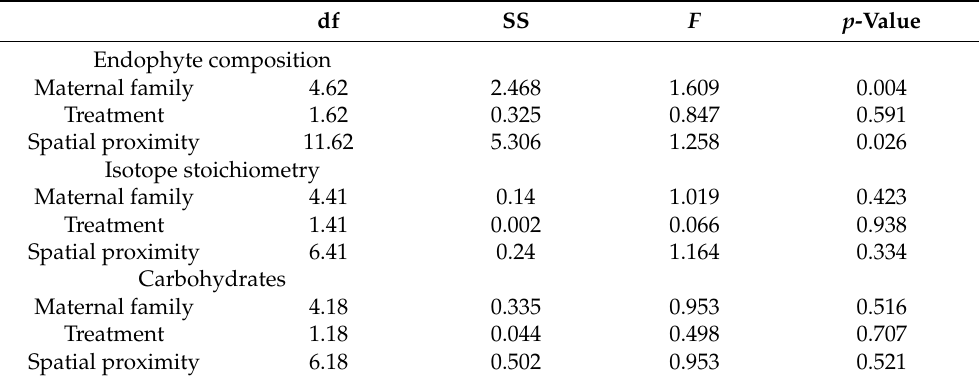
Table 2. Distance-based redundancy analysis for endophyte composition, isotope stoichiometry, and non-structural carbohydrates for predictor main effects, 999 permutations used. p -values are adjusted for simultaneous inference using Holm’s sequential Bonferroni